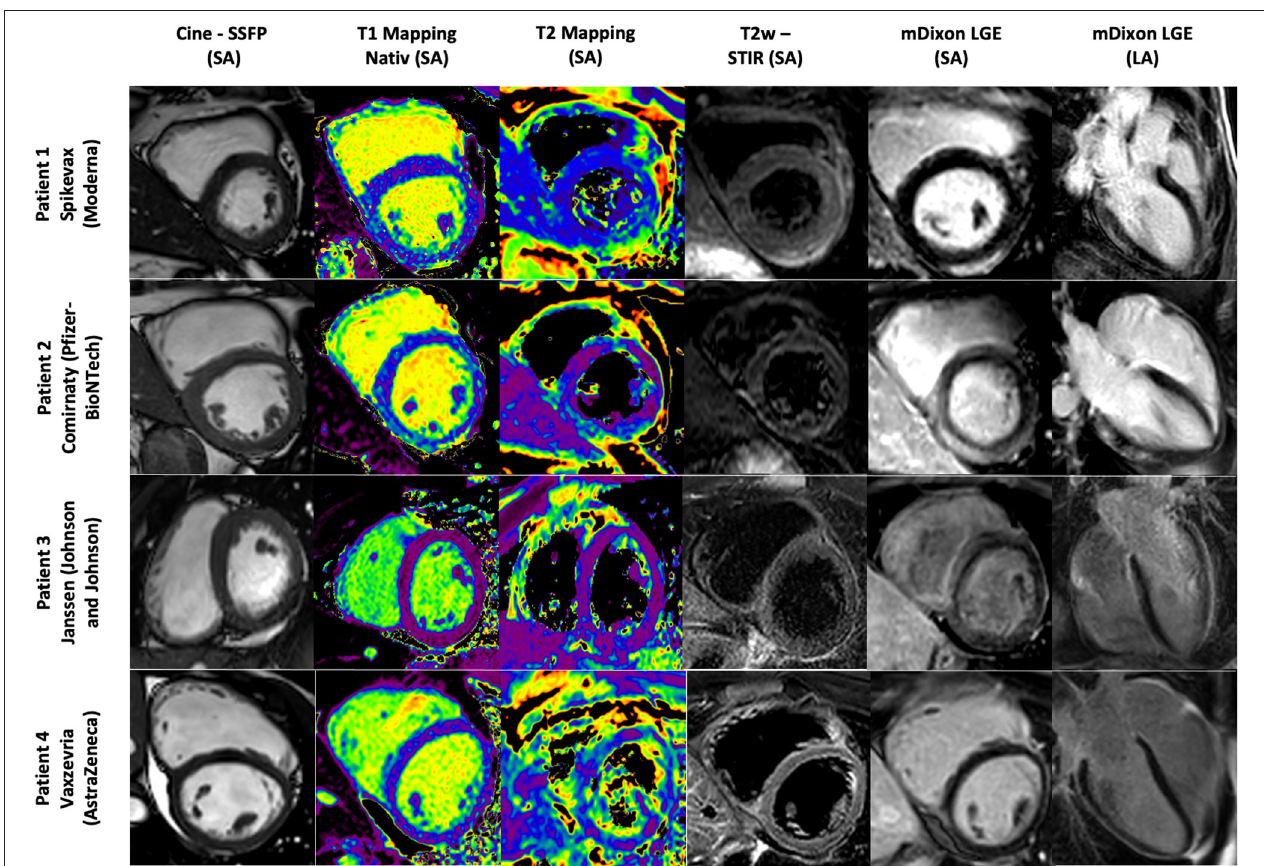
FIGURE 1 | Cardiac MR images of Patient 1–4. Patient 1 with signs of a myopericarditis after mRNA SARS-CoV-2 vaccination with Spikevax (Moderna). Patient 2 with signs of a myocarditis after mRNA SARS-CoV-2 vaccination with Comirnaty (Pfizer-BioNTech). Patient 3 with signs of a discrete pericarditis in the LV-lateral area after SARS-CoV-2 vaccination with Janssen (Johnson and Johnson). Patient 4 with a mild to moderate pericardial effusion up to 11mm in the medial posterior wall of the LV as a possible residual of an expired pericarditis/myocarditis after SARS-CoV-2 vaccination with Vaxzevria (AstraZeneca). SSFP, Stady state free precession; T2w FSE, T2-weighted fast spin echo; mDixon, Single breath-hold three-dimensional (3D) ECG-gated multi-echo chemical shift-based sequence; T1 relaxation were calculated from single breath-hold two-dimensional (2D) modified Look-Locker inversion recovery (MOLLI) sequence LA, long axis; SA, short